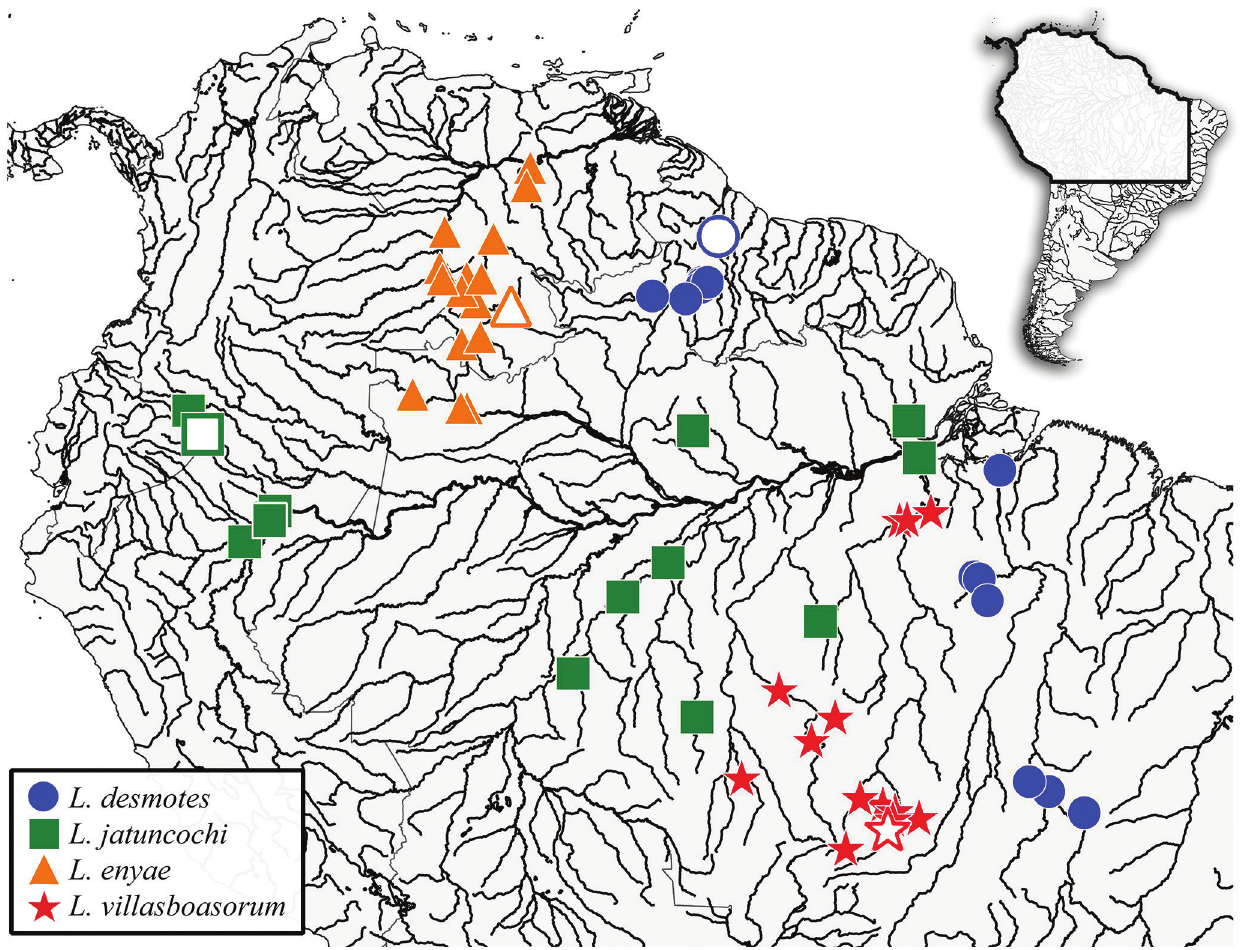
Fig. 9. Map of South America showing the distribution of Leporinus desmotes (blue circles), L. enyae (orange triangles), L. jatuncochi (green squares), L. villasboasorum (red stars). Type localities indicated by open